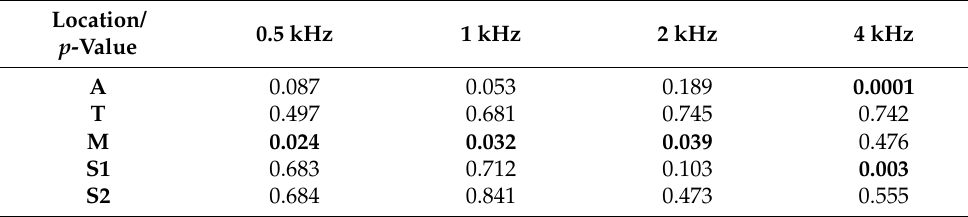
Table 3. The relationship between cholesteatoma location according to STAM and the frequency of bone conduction shifts. Test ANOVA, n = 120. For the occurrence of cholesteatoma in the attic (A), a statistically significant difference at 4 kHz ( p < 0.001) was found, in the supratubal recess (S1) at 4 kHz ( p = 0.003), and for the mastoid (M) at 0.5 kHz ( p = 0.024), at 1 kHz ( p = 0.032), and 2 kHz ( p = 0.039). Location/ 0.5 kHz 1 kHz 2 p -Value